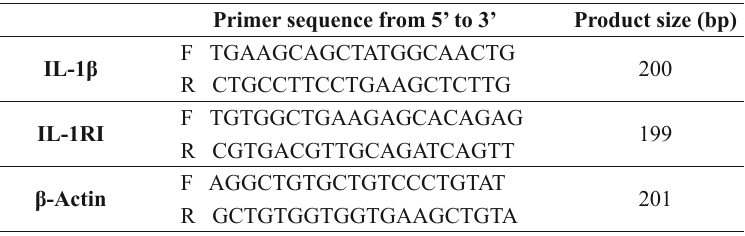
Sequence of primers used to amplify IL-1-b, IL-1RI, and b-actin. Primer sequence from 5’ to